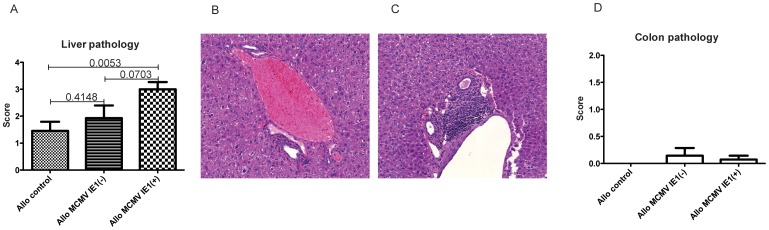
Hepatic GVHD after allogeneic HCT.Animals were transplanted as described in Materials and Methods. (A) Hepatic GVHD pathology was semiquantitatively assessed on day +100. Data are expressed as mean ± SEM. n = 11 (mock), 7 (MCMV IE1 (−)) and (MCMV IE1 (+)), respectively. (B–C) Example of histopathological changes (H&E stain, magnification: 100×) of the liver showing portal tract with moderate lymphocytic inflammation in IE1(+)>mock. (D) Colonic GVHD pathology was semiquantitatively assessed on day +100. Data are expressed as mean ± SEM. n = 11 (mock), 7 (MCMV IE1 (−)) and (MCMV IE1 (+)), respectively.